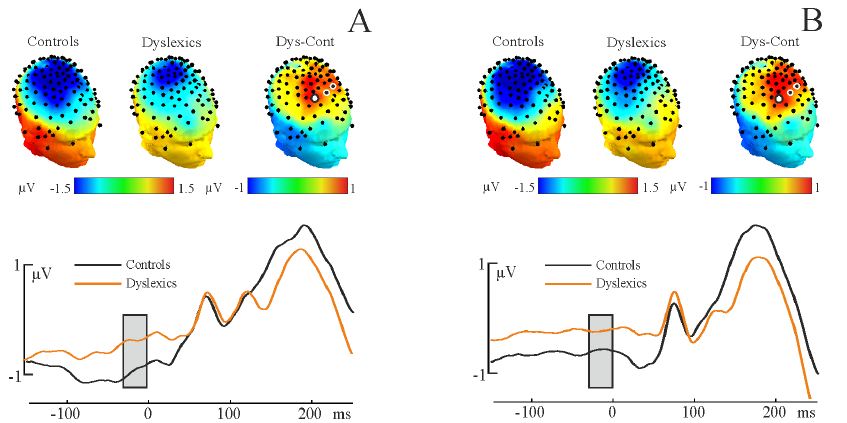
Figure 1. Time-domain event-related potentials by condition. Panel A: 2 Hz condition. Panel B: 1.5 Hz condition. Topographic headplots show the contingent negative variation (CNV) for both groups and the difference between the groups. Electrode showing significant amplitude difference in the prestimulus 2 50 to 0 ms interval after correcting for false positives are marked with larger disk. ERP traces are shown from the most significant electrode (marked with larger